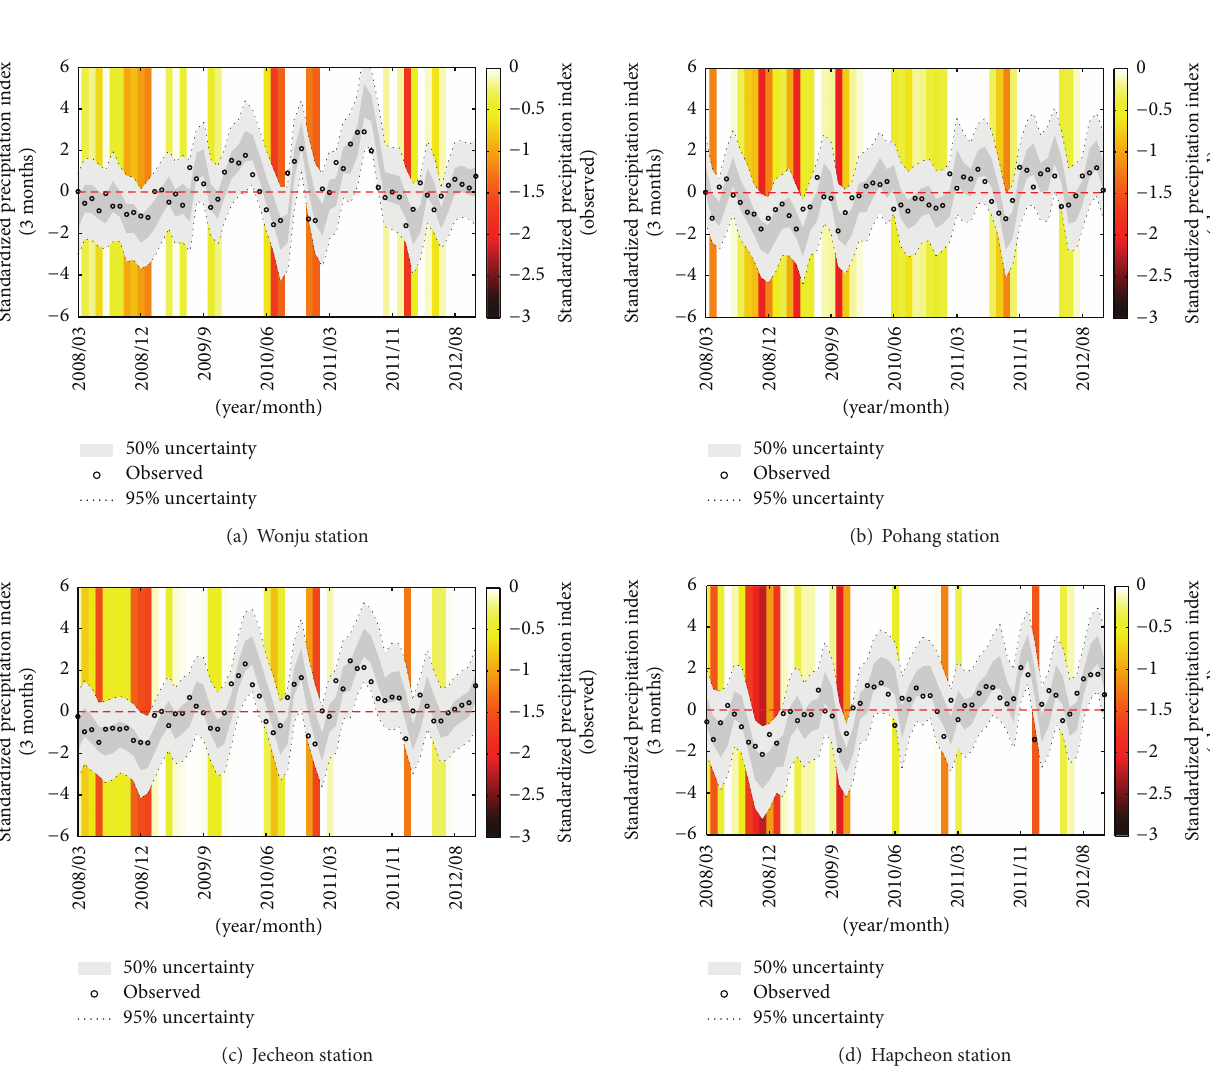
Figure 5: Results of drought forecasting (2008/03 ∼ 2012/12) with confidence interval (the drought states (SPI value is under zero) are provided with the background bar